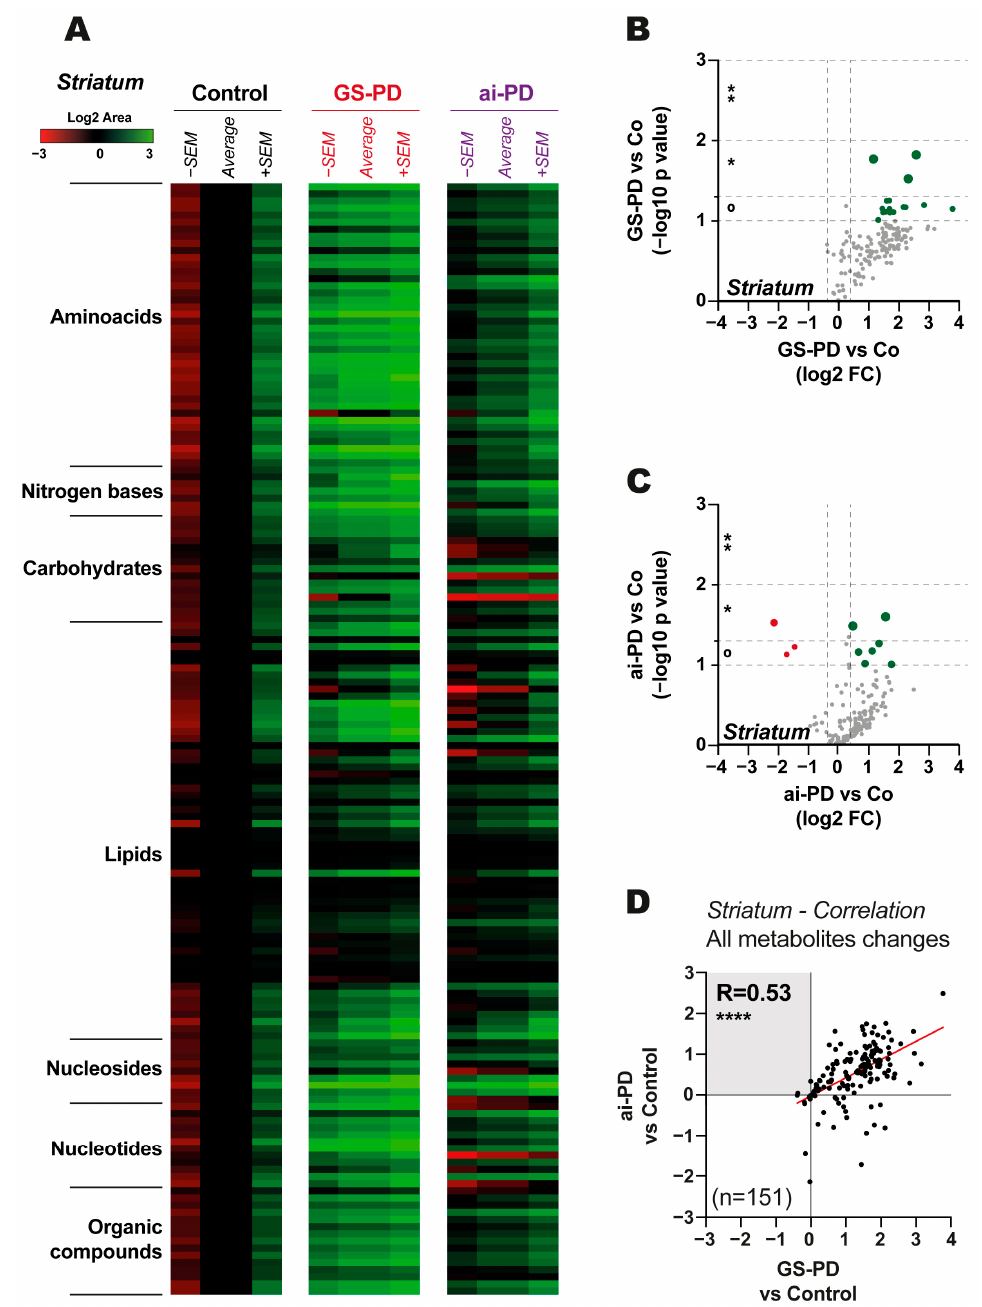
Figure 1. Results of metabolic changes observed in striatum tissues for the control (Co) and parkin- sonian genetic (GS-PD) or due to acute intoxication (ai-PD) groups ( n = 5). ( A ) Heatmap with the average of the log2 area (± standard error of the mean (SEM)) showed by metabolite groups (amino acids, nitrogen bases, carbohydrates, lipids, nucleosides, nucleotides, and organic compounds). ( B , C ) Volcano plot graphs are shown. The log2 FC shows changes observed on GS-PD model ( B ) or ai-PD model ( C ) by comparison to the control mice for each metabolite (represented by each dot). The − log10 p value represents non-significant (grey color) or significant (red represents signifi- cantly down-regulated metabolites, whereas green represents significantly up-regulated metabolites. ( D ) Correlation analysis between changes observed in striatal neurons of GS-PD compared to controls and ai-PD compared to controls. Statistical analysis was performed by obtaining p value ( ◦ ( p < 0.1), * ( p < 0.05), ** ( p < 0.01), **** ( p < 0.0001)), and Pearson’s correlation coefficient (R) between the noted